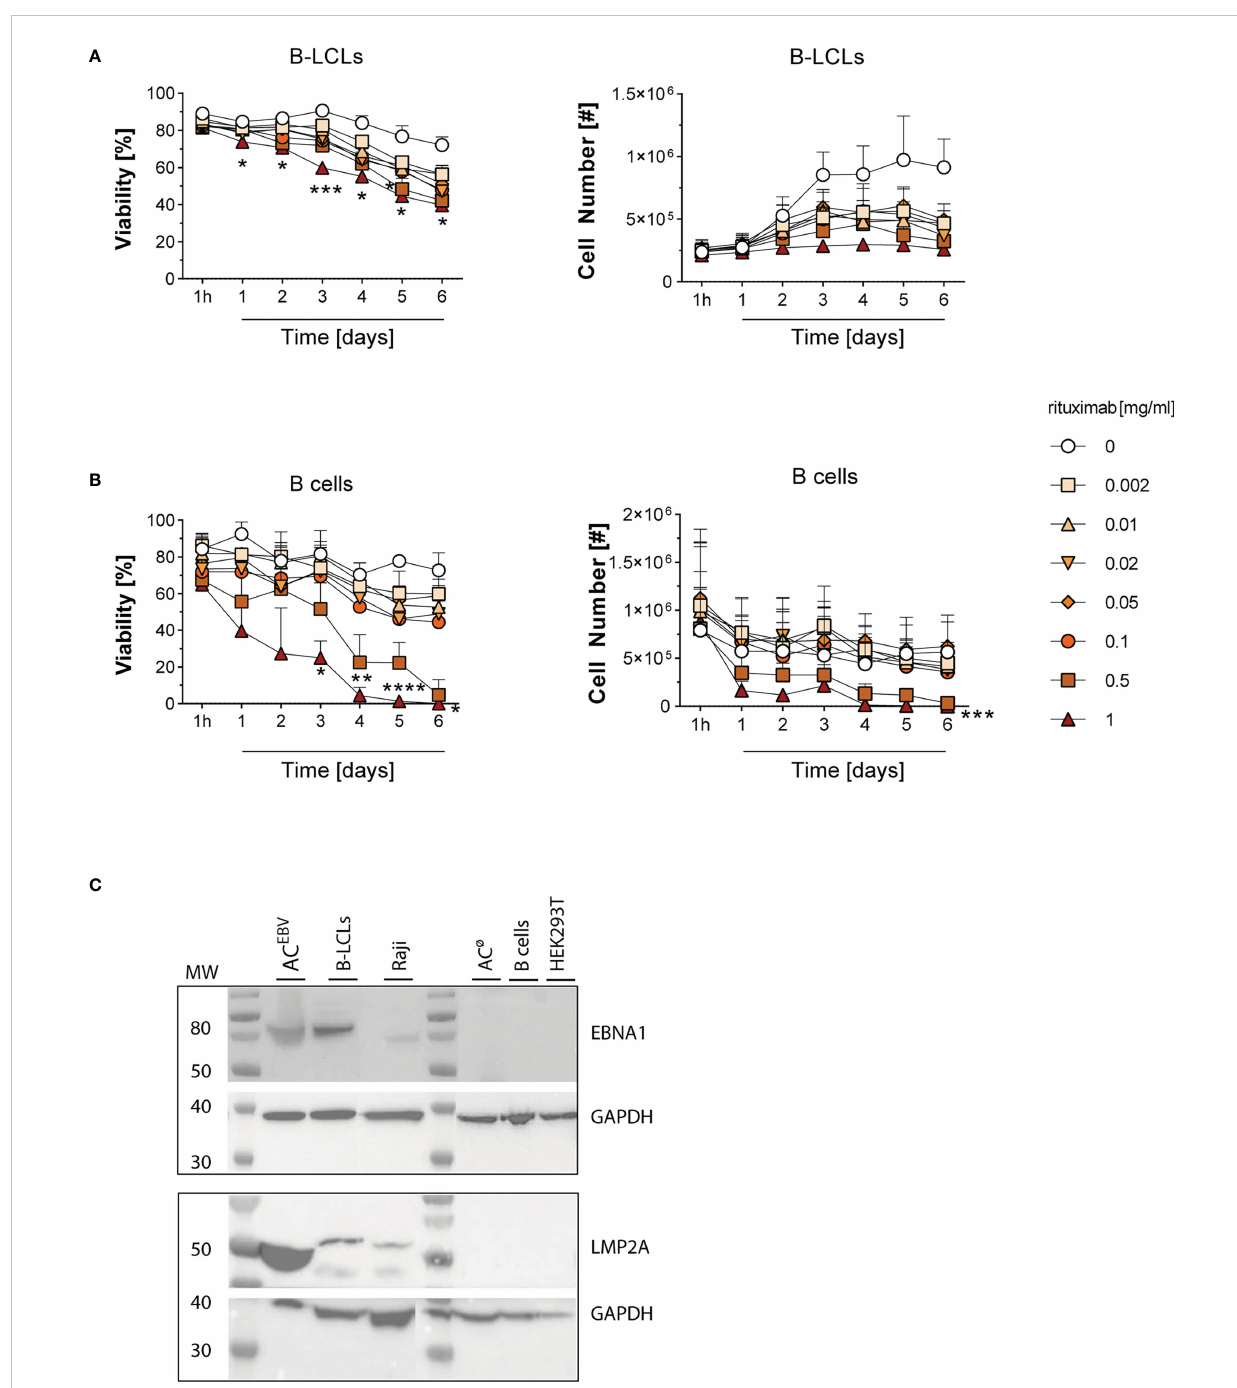
FIGURE 1 Rituximab-mediated cell lysis in B-LCLs and B cells and detection of EBV proteins in the B-LCLs lysate. Viability and total numbers of (A) EBV- immortalized B-lymphoblastoid cell lines (B-LCLs, n=3) and (B) isolated CD20 + B cells (n=3) from different healthy EBV-seropositive blood donors treated with rituximab at different concentrations (0-1 mg/ml) for one hour to six days. Results of three independent experiments for B-LCLs and B cells, respectively, are expressed as mean ± SD. Statistical signi fi cance was calculated using the 2way ANOVA test followed by multiple comparison (*p < 0.05, *pp < 0.01, ***p < 0.001, ****p< 0.0001). (C) Detection of EBV proteins EBNA1 and LMP2A in lysate of rituximab-treated B- LCLs (AC EBV , 1 mg/ml rituximab for three days) by western blot immunostaining. Cell lysates from the respective B-LCLs and Raji cells were used as positive control, whereas HEK293T, B cells and rituximab-treated B cells (AC ø ) served as negative control. Glyceraldehyde-3-phosphate dehydrogenase (GAPDH) was used as loading control. MW - molecular